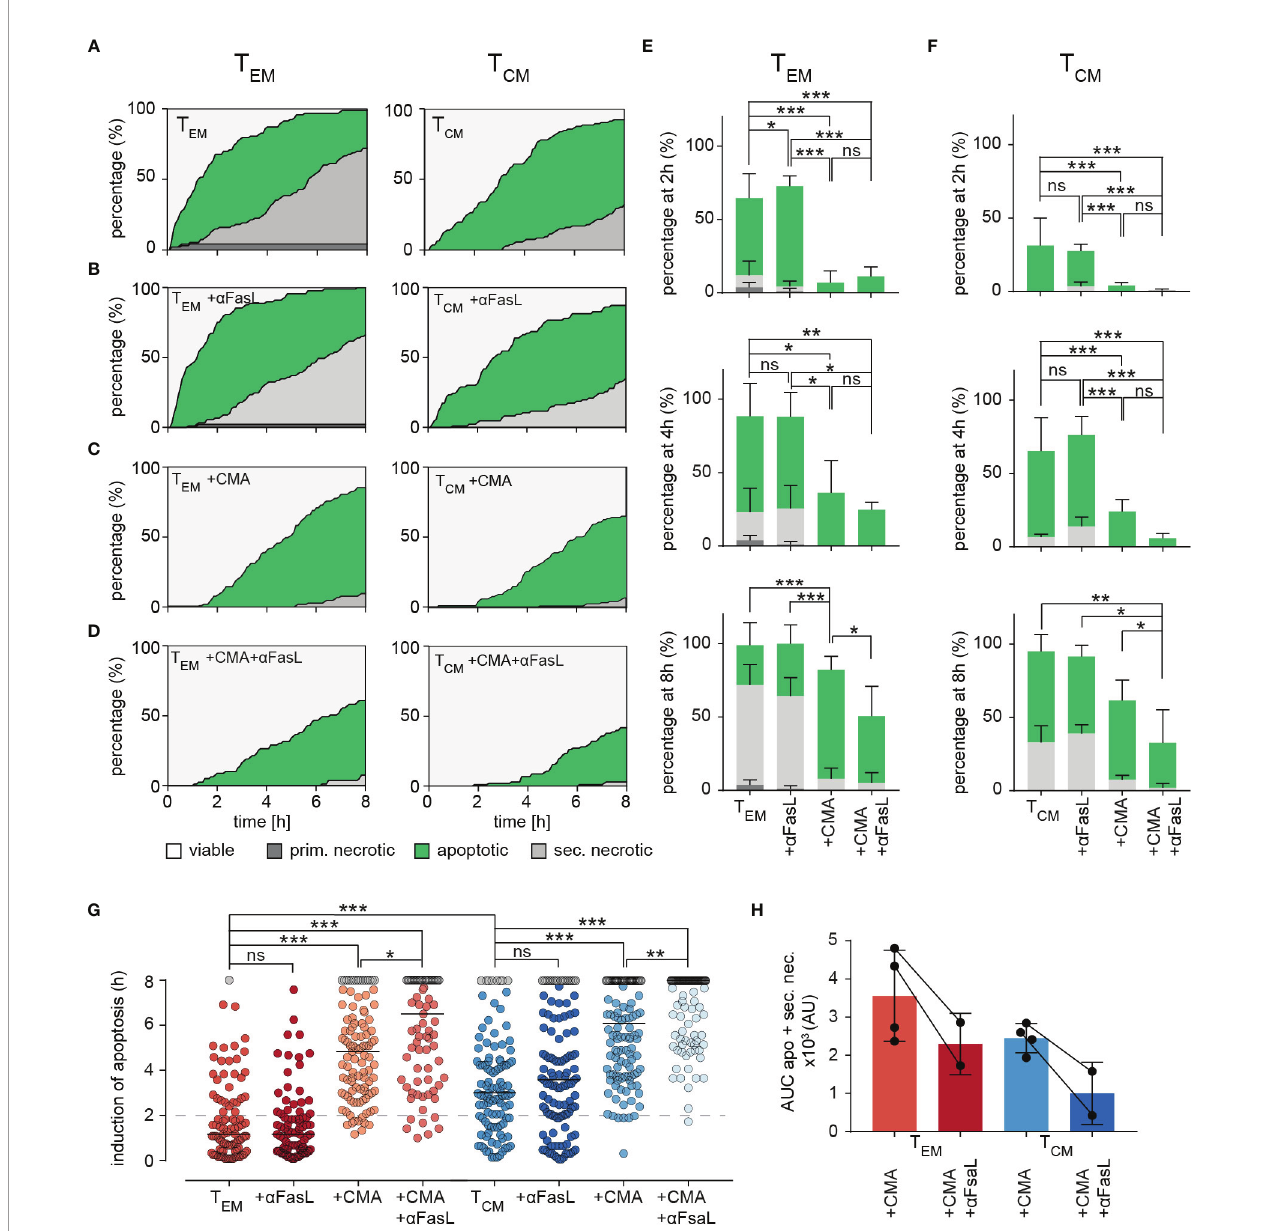
FIGURE 6 | Dissectingkilling mechanisms of T EM and T CM . (A) To analyze target cell lysis byperforin-mediated orFasR-mediatedkilling mechanisms, sorted T EM orT CM andtarget cell were either un-treated as control (A) or treatedwith inhibitingFasL antibodies NOK-1 and NOK-2 (10 µg/each) (B) , with 50 nM CMA (C) andwith inhibiting FasL antibodies andCMA incombination (D) . Effects of treatments onT EM andT CM are shownas representative death plots, respectively (A-D) . (E,F) Quanti fi cation of targetcelllysisat2h, 4h and8hfor T EM (E) or T CM (F) . (G) D t of apoptosis for each analyzed target celllysed by treated T EM orT CM in comparison to untreated (T EM or T CM ) control cells. (H) Impact of FasL blocking quanti fi ed byanalysisofareaunder the curve(AUC). Each point re fl ects the D t ofapoptosisinduction froma single target cell. n=4 donors, T EM 94 cells, + a FasL89 cells, +CMA103, +CMA+ a FasL (n=2 donors) 79, T CM 105 cells, + a FasL 122 cells, +CMA (n=2 donors) 122 cells, +CMA+ a FasL 102 cells. Statistical analysis was done usinga two-way ANOVA. *p<0.05; **p<0.01; ***p<0.001; ns, nosigni fi cant